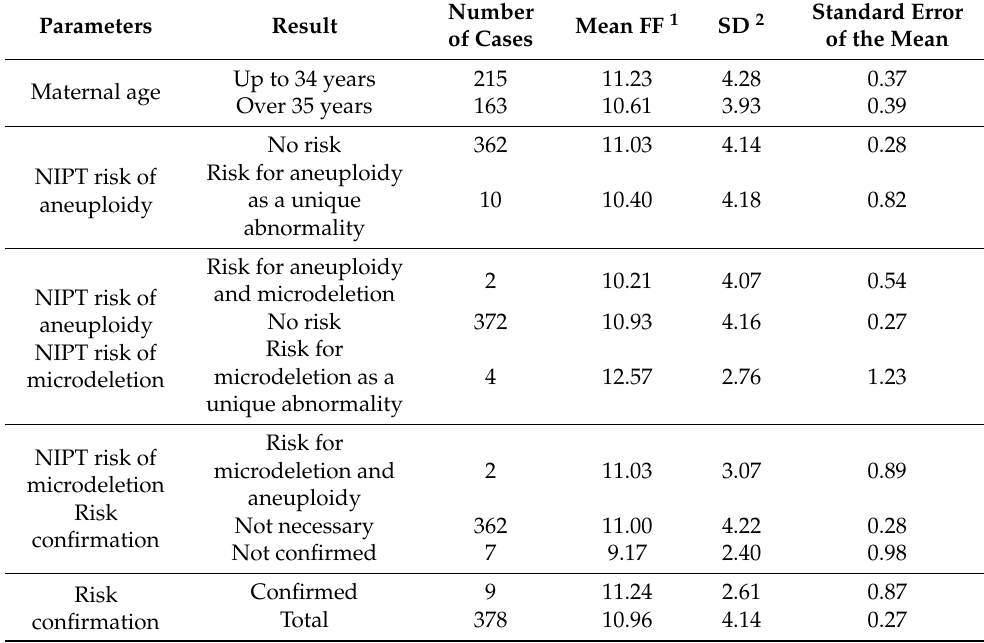
Table 1. Fetal fraction descriptive statistics for different parameters.